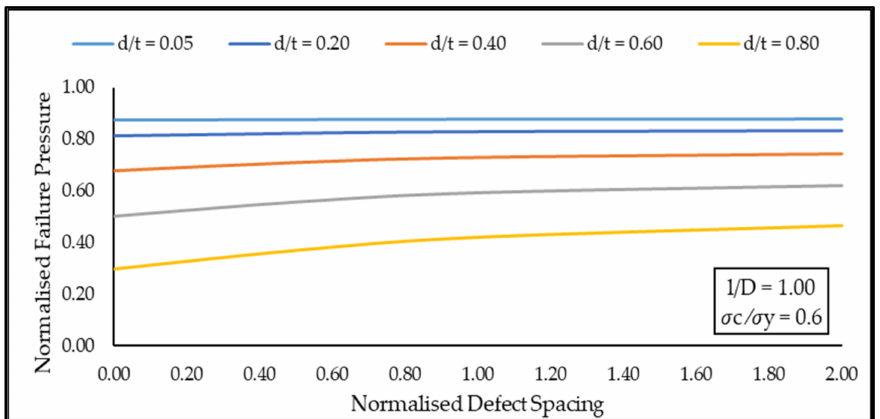
Figure 14. Normalized failure pressure predictions based on the empirical equation against various normalized defect spacing for multiple normalized defect depths at constant normalized defect length of 1.00 and normalized axial compressive stress of